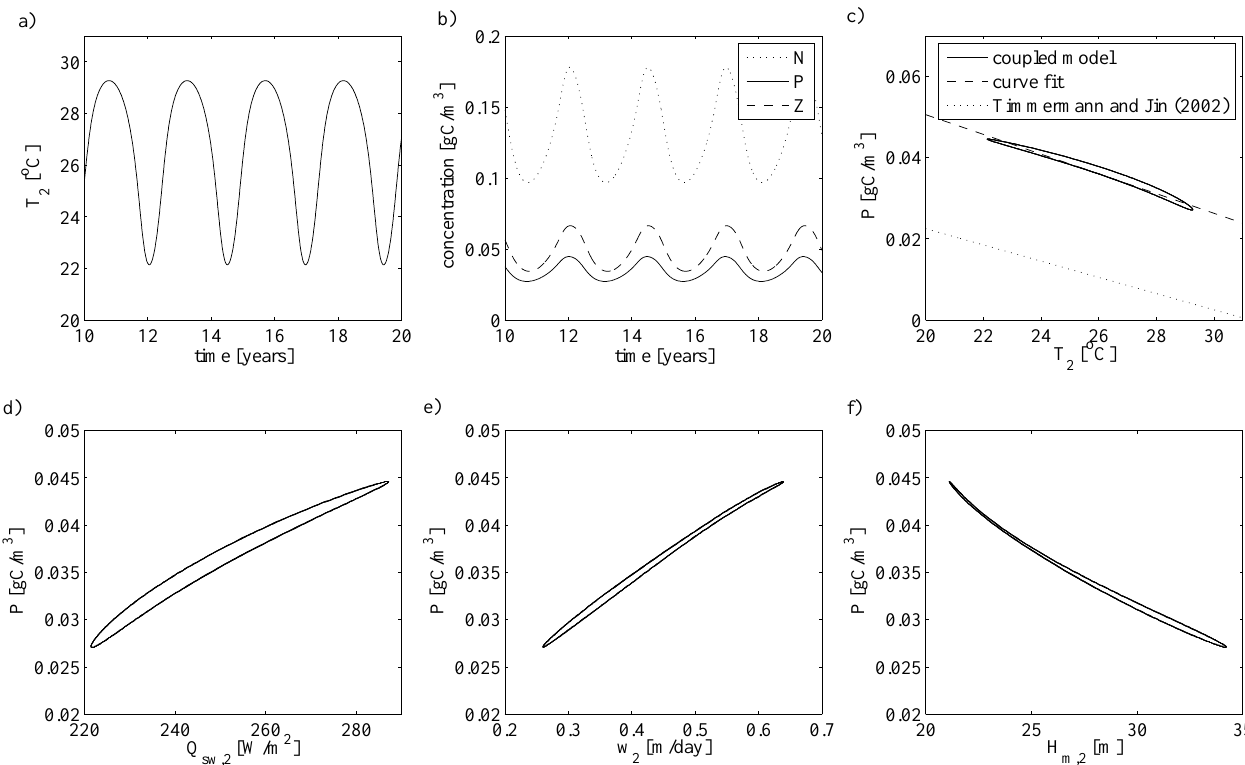
Fig. 3. (a) Timeseries of the eastern SST T 2 ; (b) timeseries of the nutrient concentration N, phytoplankton P and zooplankton Z; (c) phase- space plot of phytoplankton P vs. eastern SST T 2 (solid line), least square curve fit (dashed line; P =− 0 . 0273gCm − 3 –0.0024gCm − 3 ◦ C − 1 ( T 2 –30 ◦ C)), and chlorophyll-temperature relation as used by Timmermann and Jin (2002) (dotted line, for a strong bio-physical coupling P = − 0 . 0025gCm − 3 − 0 . 0020gCm − 3 ◦ C − 1 ( T 2 –30 ◦ C), assuming a chlorophyll to carbon ratio of 50mgC(mgchl) − 1 ); (d) – (f) phase- space plots of phytoplankton P vs. short-wave heatflux Q sw , 2 , upwelling velocity w 2 and eastern mixed layer depth H m , 2 ; parameters from Tables 1 and 2.